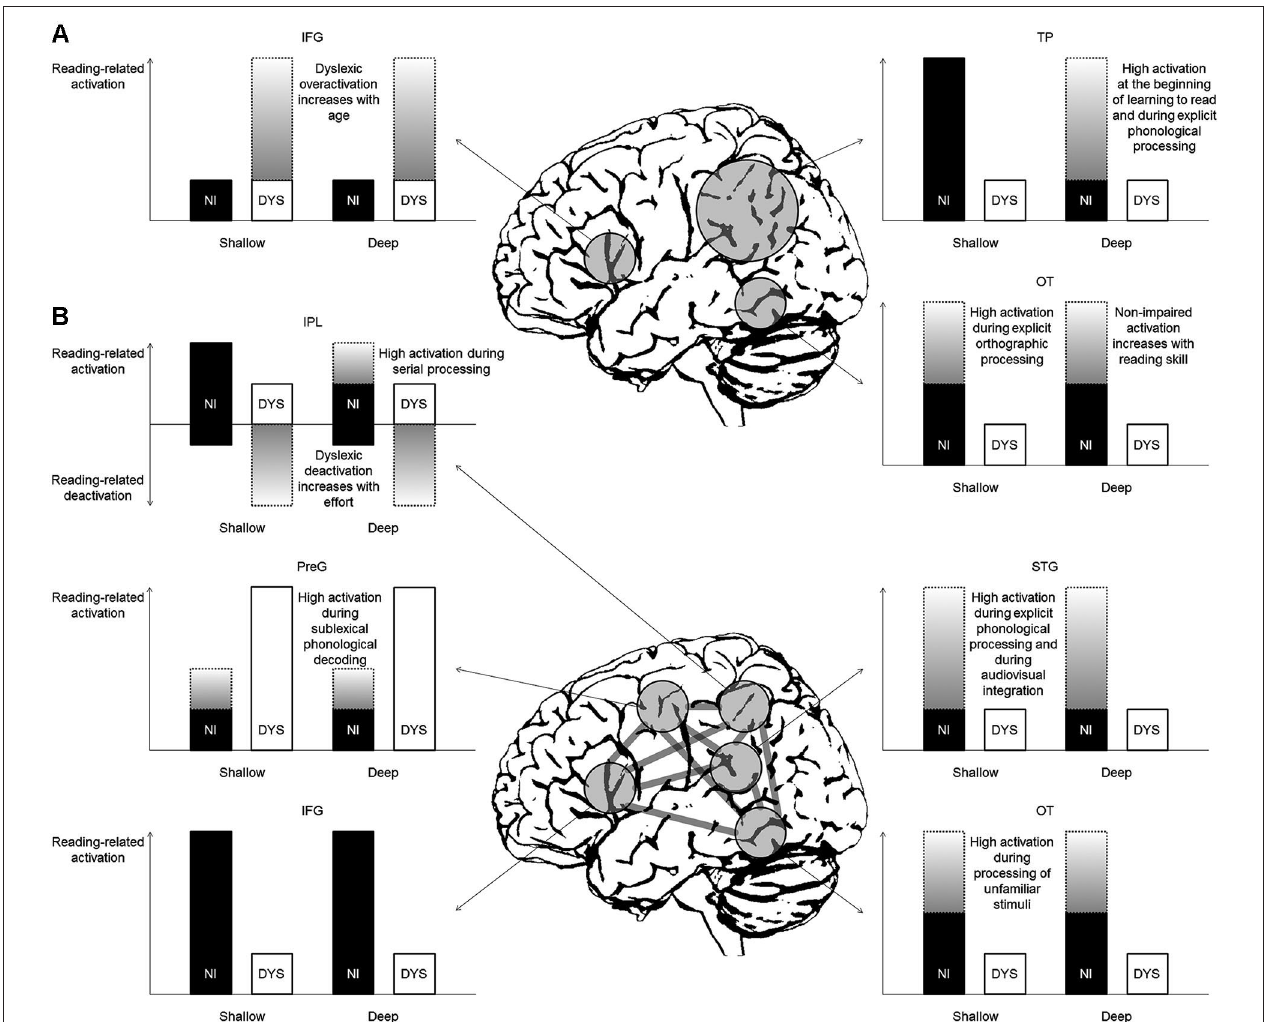
present under certain conditions (for detailed explanations see text). IFG = inferior frontal gyrus, IPL = inferior parietal lobule, OT = occipito-temporal cortex, PreG = precentral gyrus, STG = superior temporal gyrus, TP = temporo-parietal